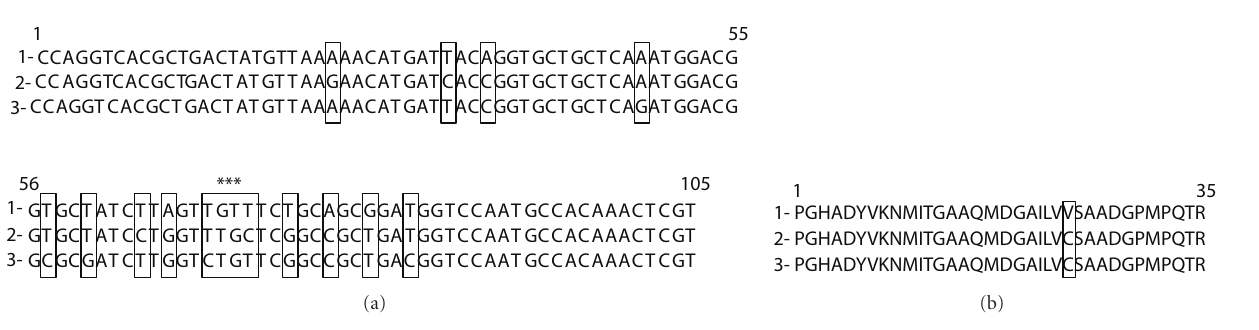
Figure 5: Results of alignment of the nucleotide (a) and amino acid (b) sequences of the fragment of tufB -gene of cells (1) and EMVs (2) of A. laidlawii PG8 as well as amplicon (3) obtained as a result of PCR with primers for detection of the nucleotide sequence of tufB -gene of A. laidlawii PG8 when DNA of plants grown in EMVs-containing medium was used as a matrix. Sequences of forward and reverse primers are